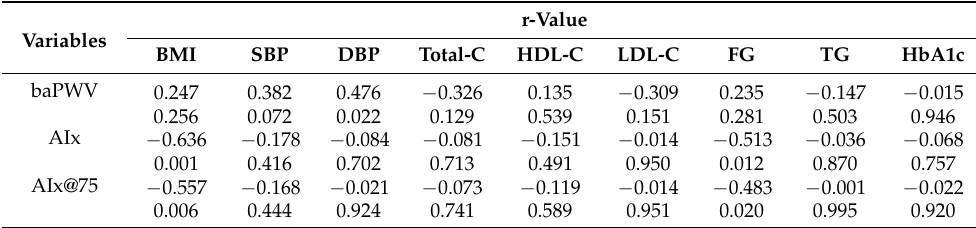
Table 4. Association between arterial stiffness (baPWV, AIx, and AIx@75) and cardiometabolic risk factors.